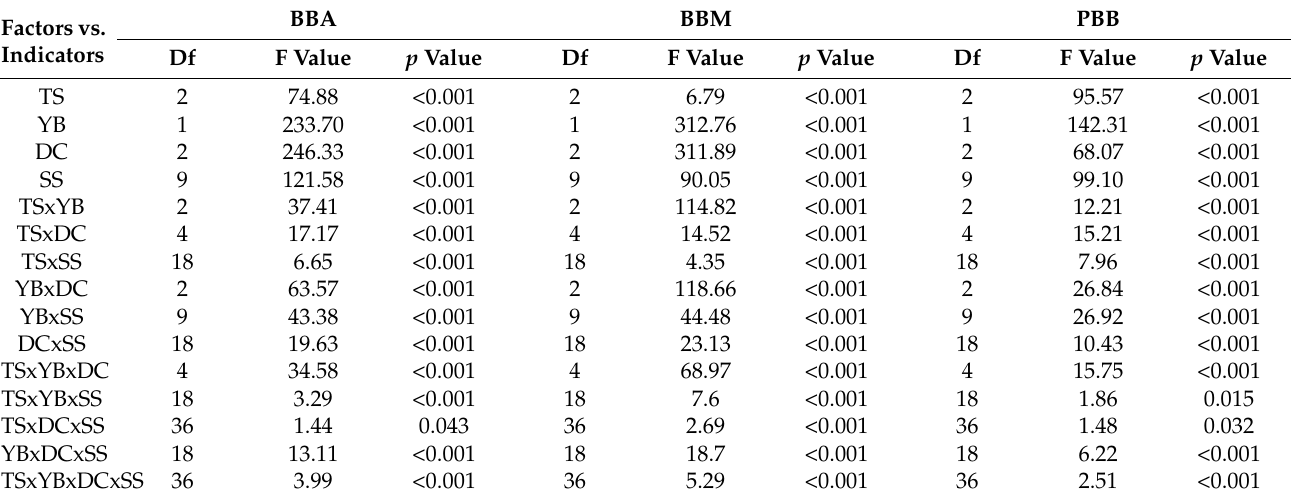
Table 3. Four-way ANOVA evaluating the influences of tree species (TS), year of browsing by large wild herbivores (YB), diameter class (DC), and stem section (SS) on the browsed bark area (BBA), browsed bark mass (BBM), and browsed bark mass to total bark mass (PBB) caused by large wild herbivores. Tree species were represented by common aspen ( Populus tremula L.), common rowan ( Sorbus aucuparia L.), and goat willow ( Salix caprea L.).